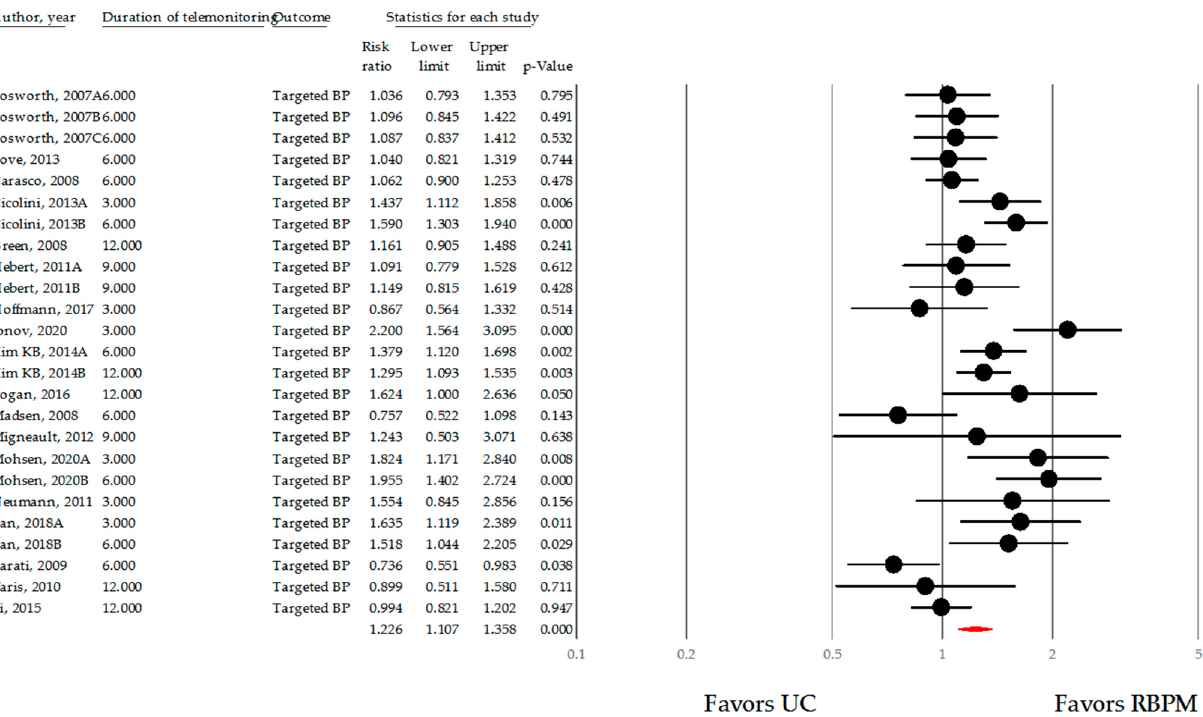
Figure 7. Risk ratio of target blood pressure using remote blood pressure monitoring. Note: point estimate of individual study ( ● ), summary effect size ( ◆ ); BP, blood pressure; UC, usual care; RBPM, remote blood pressure monitoring.